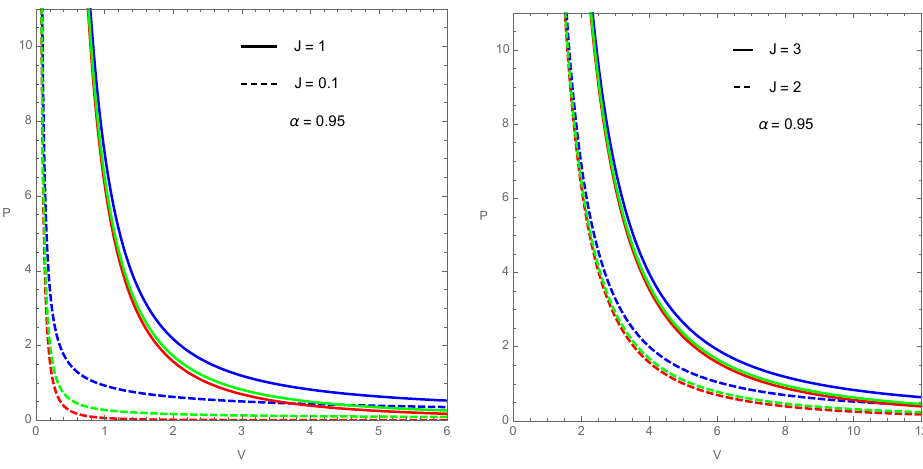
Figure 2 . PV diagram for (cid:11) = 0 : 95, (cid:13) = 0 : 05, J = 0 : 1 ; 1 (left) and J = 2 ; 3 (right), and T = 0 : 001 (red), T = 0 : 5 (green), T = 2